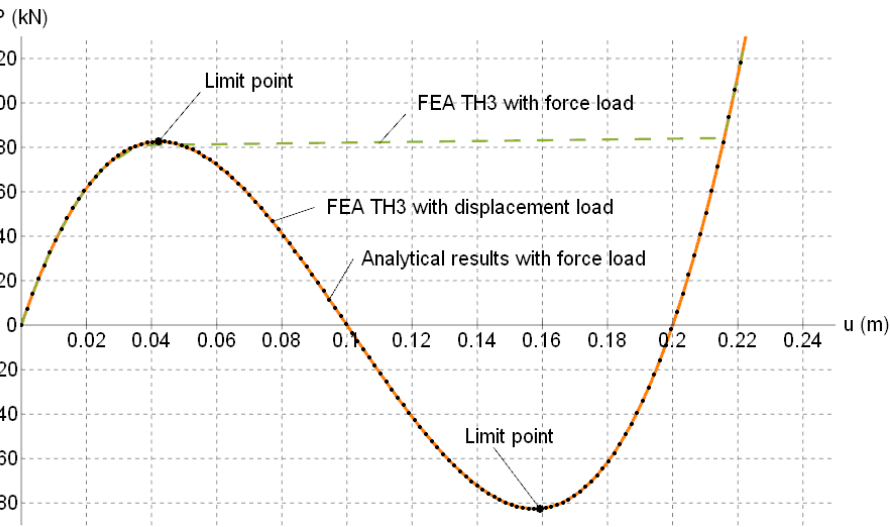
Figure 4: Equilibrium paths for von Mises truss from different types of analysis. The vertical axe represents applied force and the horizontal axe represents the displacement of the point where the load is applied. FEA TH3 with displacement results (continuous) match exactly the analytical results with force load (dotted).